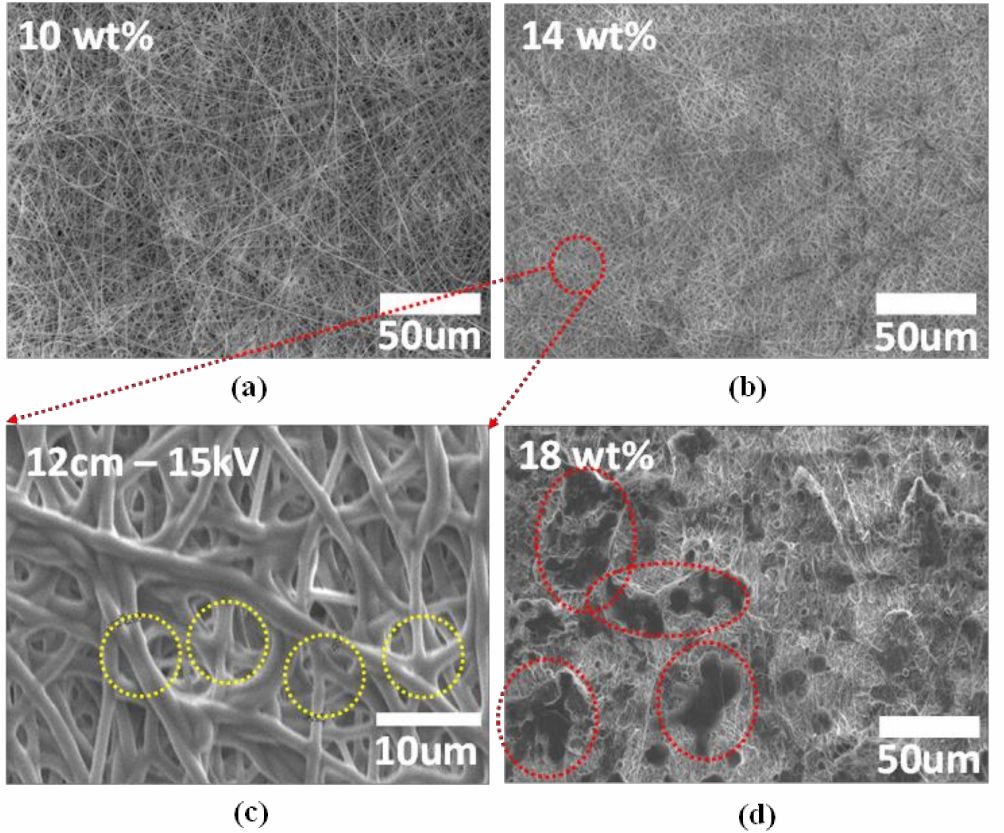
Figure 2. ( a – d ) SEM images showing the morphological variation of as-electrospun PVDF- co -HFP fibers with the different concentrations of the PVDF- co -HFP copolymer dissolved in the co-solvent of NMP and acetone. Note that ( c ) represents the magnified SEM image of ( b ) to highlight the cross-linked area marked by the yellow